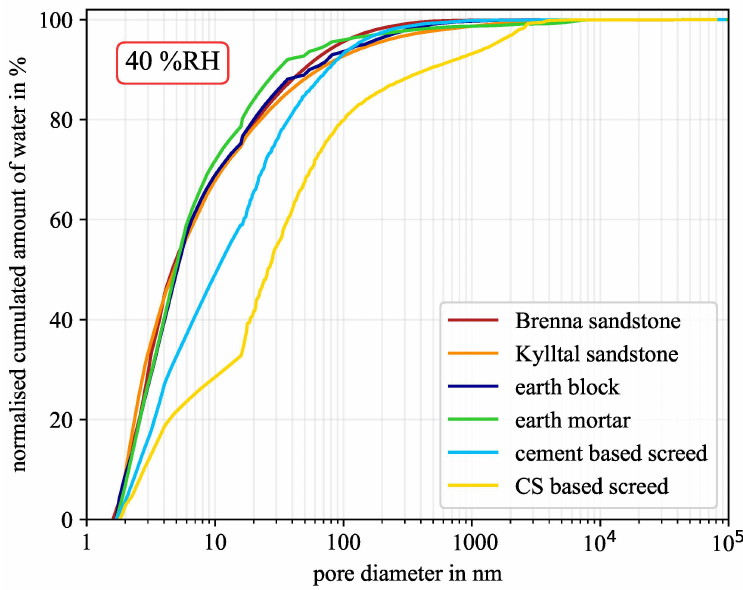
Figure 6. Normalised cumulated amount of water at 40% RH for the six material samples. (CS—calcium